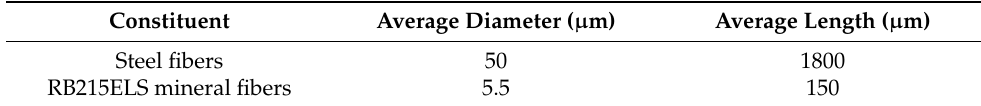
Table 1. Geometry of steel fibers and RB215ELS mineral fibers.